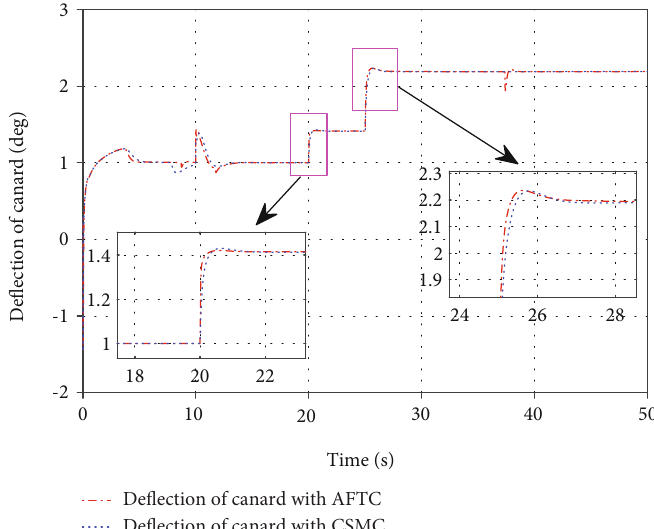
Figure 8: De fl ection of canard control surface in the presence of concurrent elevator and canard control surface faults in scenario